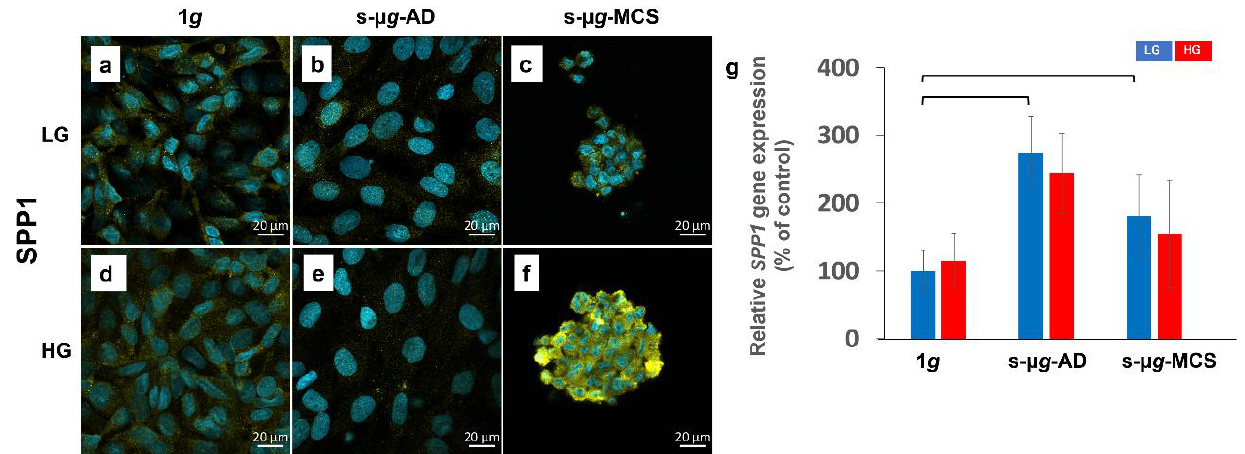
Figure 8. Analysis of SPP1 after 14 days of cultivation either at 1 g or on the clinostat, either using low (LG) or high (HG) glucose medium. Data were obtained by immunostaining ( a – f ) and qPCR ( g ). The two brackets stand for a significance level of p < 0.05.